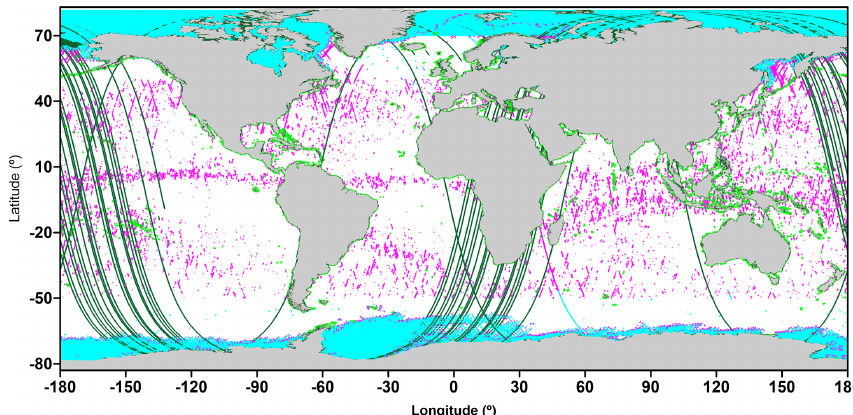
Figure 4. Invalid MWR-derived WTC for Envisat cycle 12: (i) correction contaminated due to ice, (ii) correction contaminated due to rain and outliers; (iii) points flagged as coastal, may possess a correction contaminated by land; (iv) no available MWR-derived WTC value (the “fill value” is given). A note must be made that there are several points with an available MWR-derived field but with an invalid value and without any error flag that are detected and flagged by the GPD +